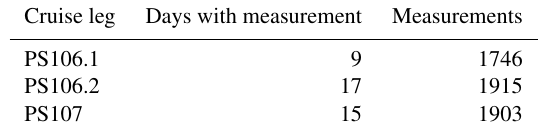
Table 1. Number of radiance measurements per cruise leg. Only measurements for which there is a successful retrieval are consid- ered.